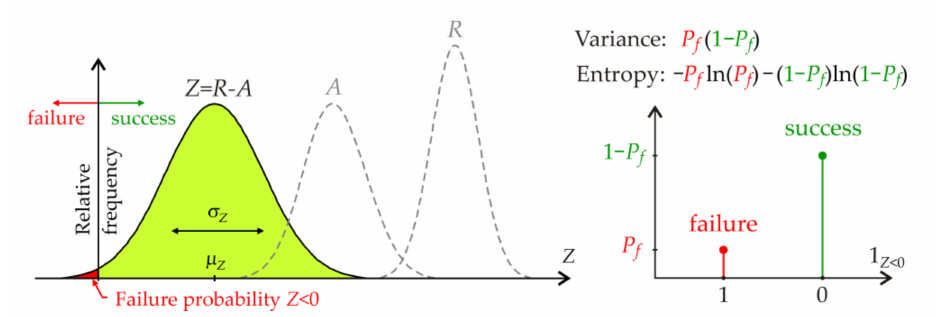
Figure 1. The failure probability P f and Bernoulli